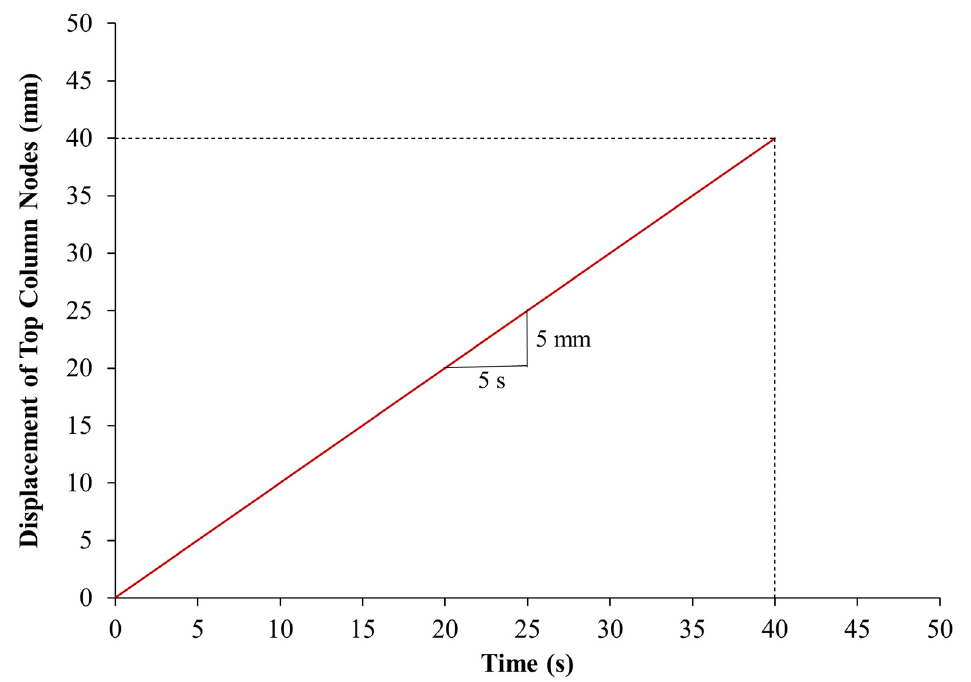
Figure 13. Displacement–time history for top column nodes.